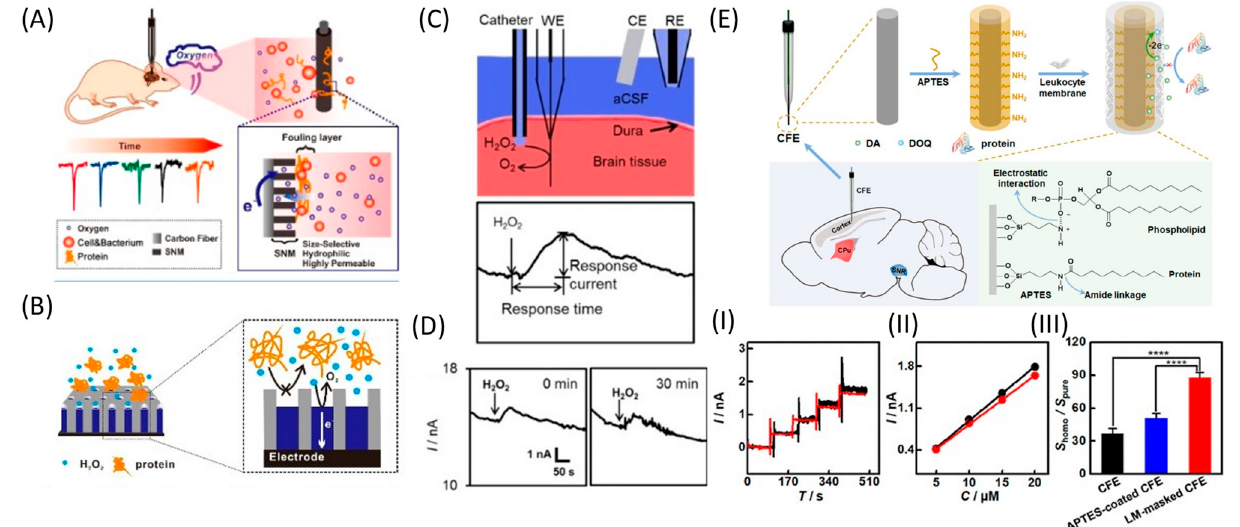
Figure 8. Different antifouling approaches. ( A ) Illustration of hydrophilic, highly permeable, and antibiofouling SNM-coated CFME for continuous monitoring of O 2 in the rat brain. Reproduced from [110], copyright 2019 American Chemical Society. ( B ) Schematic diagram of the low-fouling Pt@SNM-coated electrode for H 2 O 2 detection. ( C ) Scheme of intermittent in vivo monitoring of H 2 O 2 by Pt 80 @SNM/CFME in the rat brain. ( D ) In vivo monitoring of H 2 O 2 by Pt 80 @SNM/CFME implanted in the cortex of the rat brain for 1.5 h, whereby 1 µL of 0.5 mM H 2 O 2 was injected for 20 s every 30 min. Reproduced from [91], copyright 2020 Wiley-VCH Verlag GmbH & Co. KGaA. ( E ) Scheme of CFE modification with leukocyte membrane for in vivo detection DA. (I) Typical amperometric responses with the LM-masked CFE toward successive additions of DA (each addition was 5 µM) in pure aCSF (black curve) and homogenate-containing aCSF (red curve). (II) Calibration curves obtained with the LM-masked CFE in pure aCSF (black curve) and homogenate-containing aCSF (red curve). (III) Ratios of the sensitivity in homogenate-containing aCSF to those in pure aCSF; n = 4. The asterisks (****) indicate significant differences, p < 0.0001, one-way ANOVA. Reproduced from [70], copyright 2019 American Chemical Society.